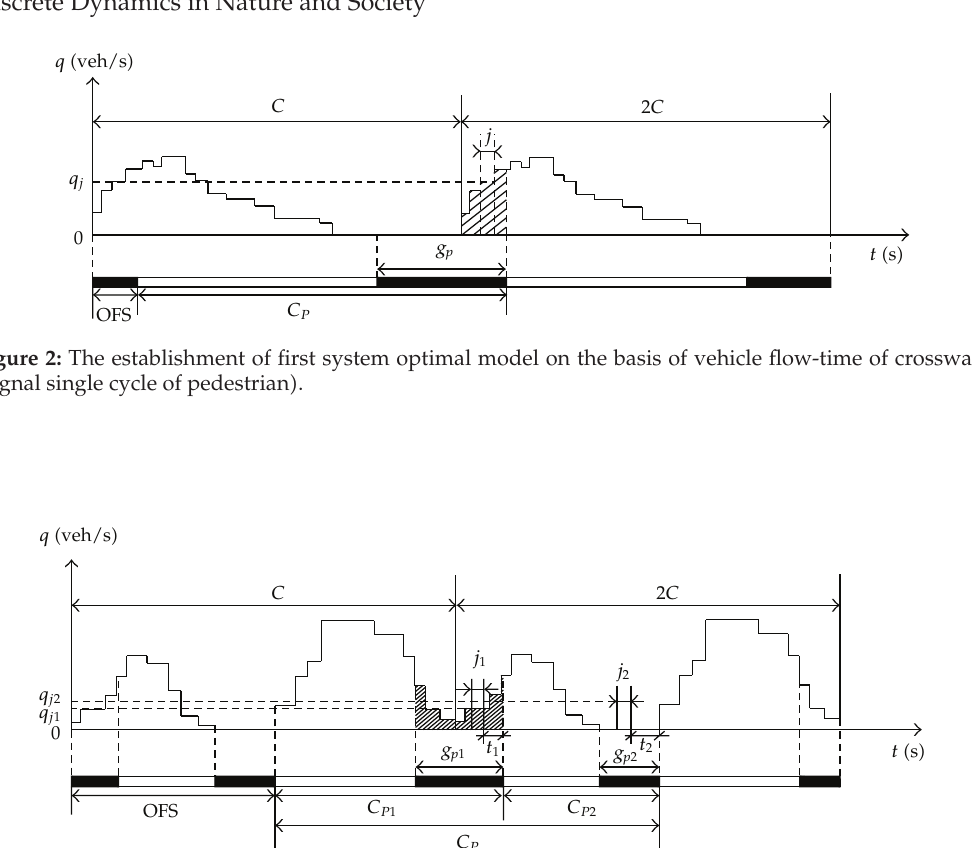
e pr —actual serving capacity of pedestrian mid-block crossings (cid:4) person/green hour · m (cid:5) ; d — width of pedestrian mid-block crossings (cid:4) m (cid:5) ; l —length of pedestrian mid-block crossings,